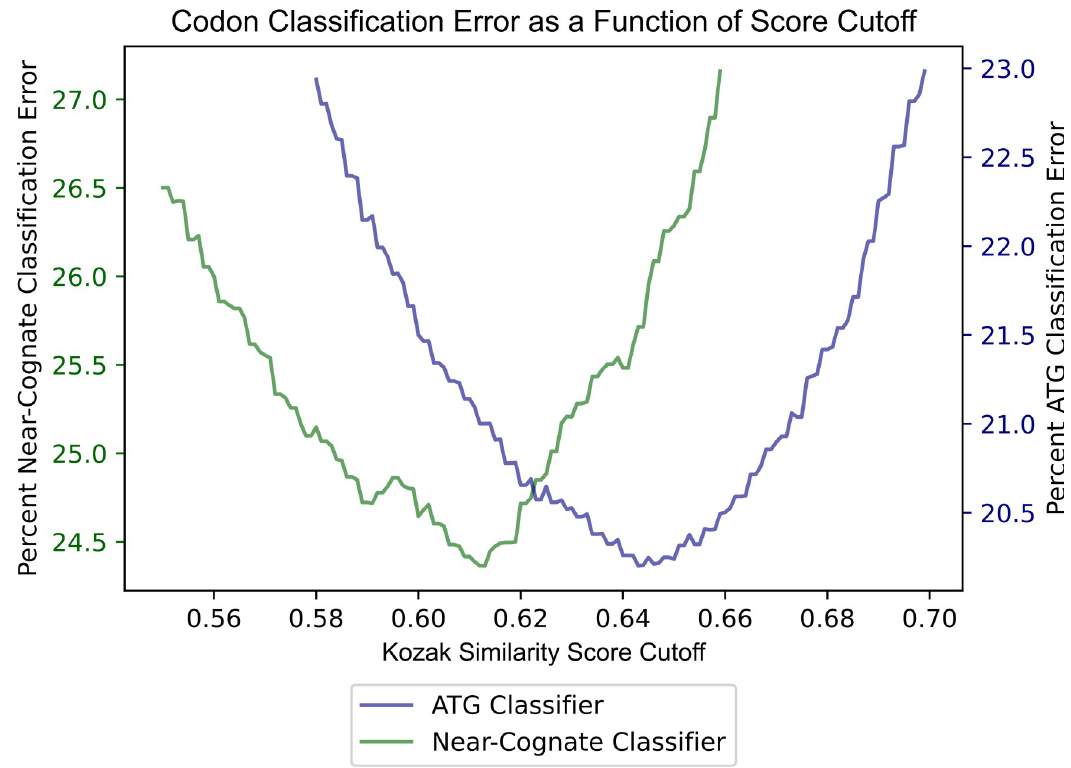
Fig 4. Error classifying ATG and near-cognate codon ability to initiate translation using Kozak similarity score.